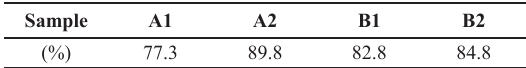
Figure V: Free opening rate as a function of the steel treatment time. A1, A2, B1 and B2 filler sands. Table IV. Free opening rate (%) according to the type of sand. Time, temperature and steel quality were fixed.